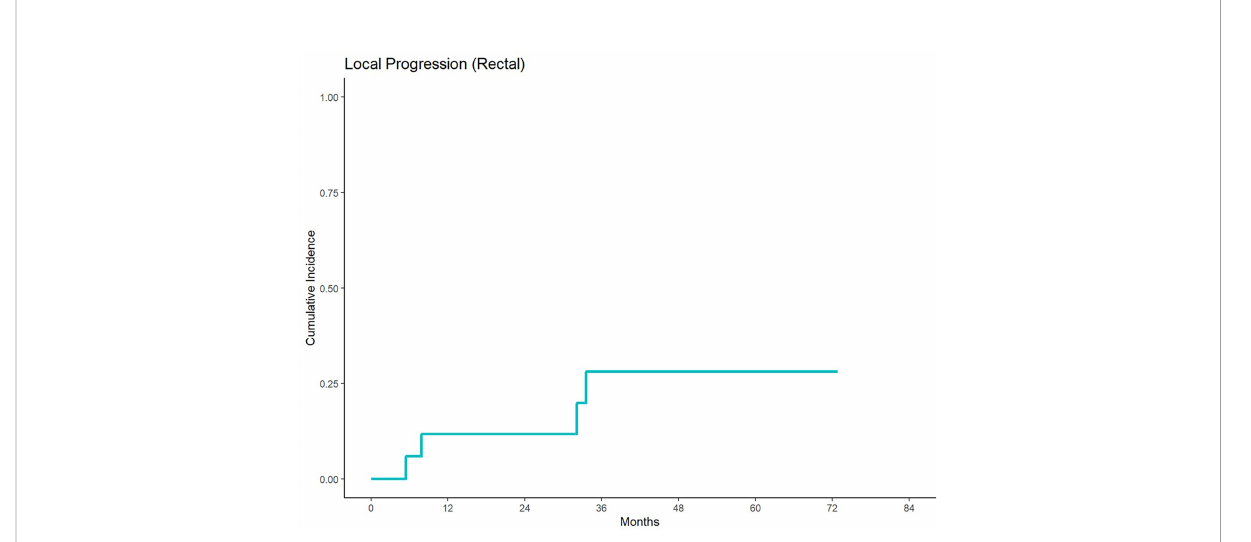
FIGURE 2 Cumulative incidence of local progression for patients treated with a second course of pelvic radiation for de novo rectal cancers after prior prostate